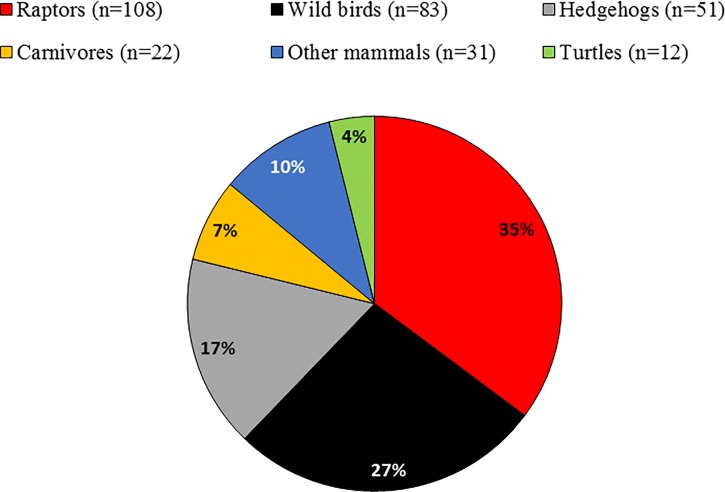
Proportion of wildlife analysed in the study according to the zoological category.Animal groups: raptors (different species of birds of prey and owls), wild birds (principally passerines and seagulls), insectivorous (European and Algerian hedgehogs), carnivores (mainly mustelids), and other mammals (wild boars and roe deer).